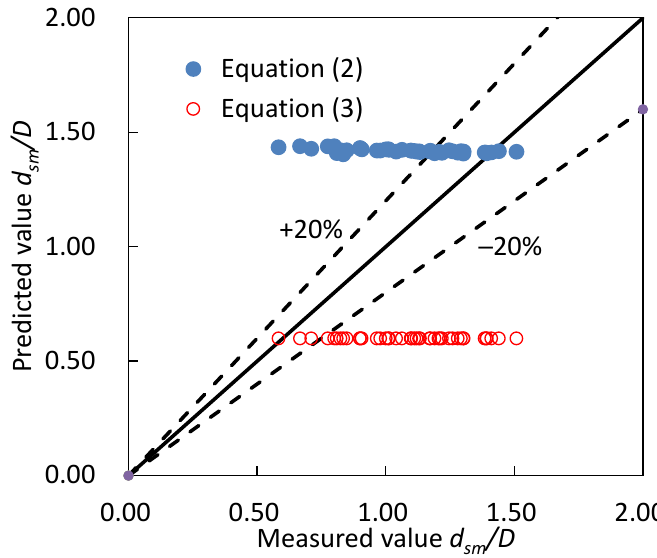
Figure 11. Comparisons of measured and predicted scour depth using Equations (2) and (3).